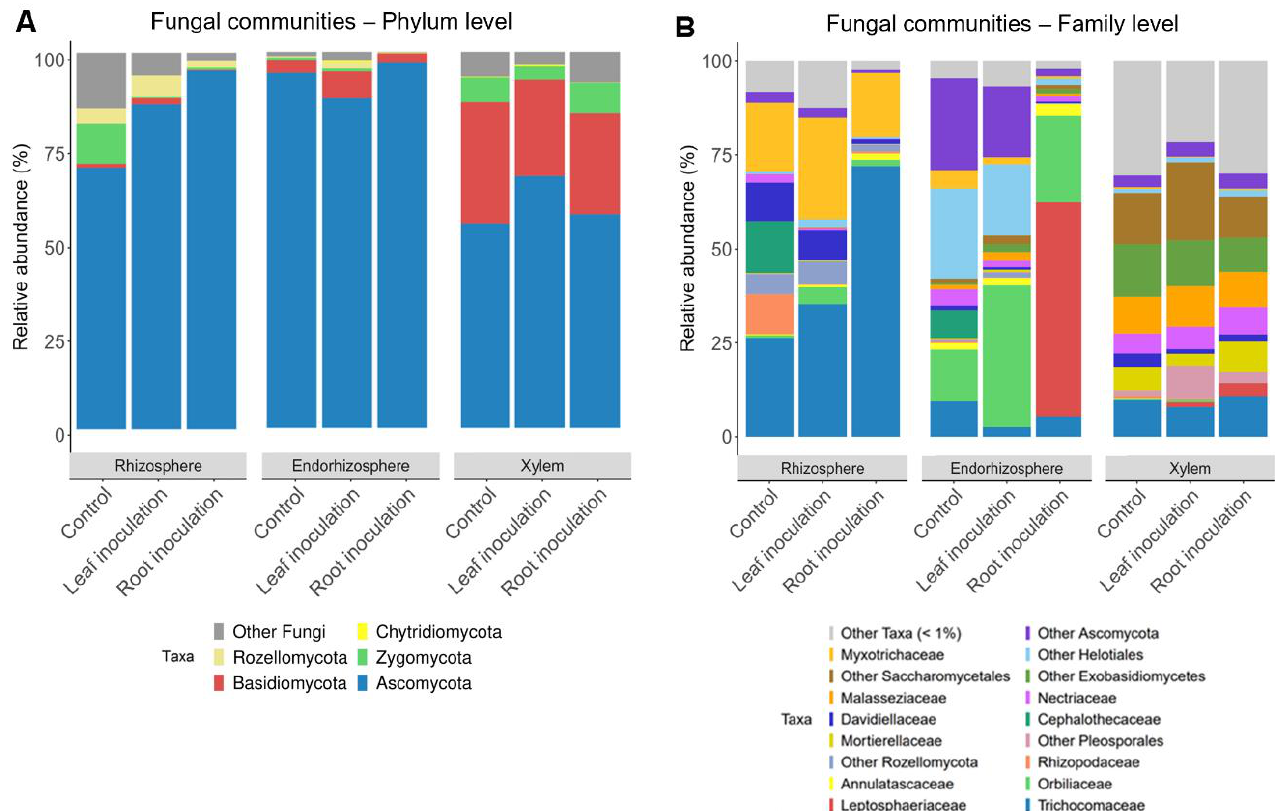
Figure 3. Relative abundances of the fungal communities at the phylum ( A ) and family ( B ) taxonomic levels in the rhizosphere, endorhizosphere, and xylem compartments of control (non-inoculated) and inoculated (through leaves or roots) sour orange seedlings. Fungal family taxa less abundant than 1% are reported as “Other Taxa”.